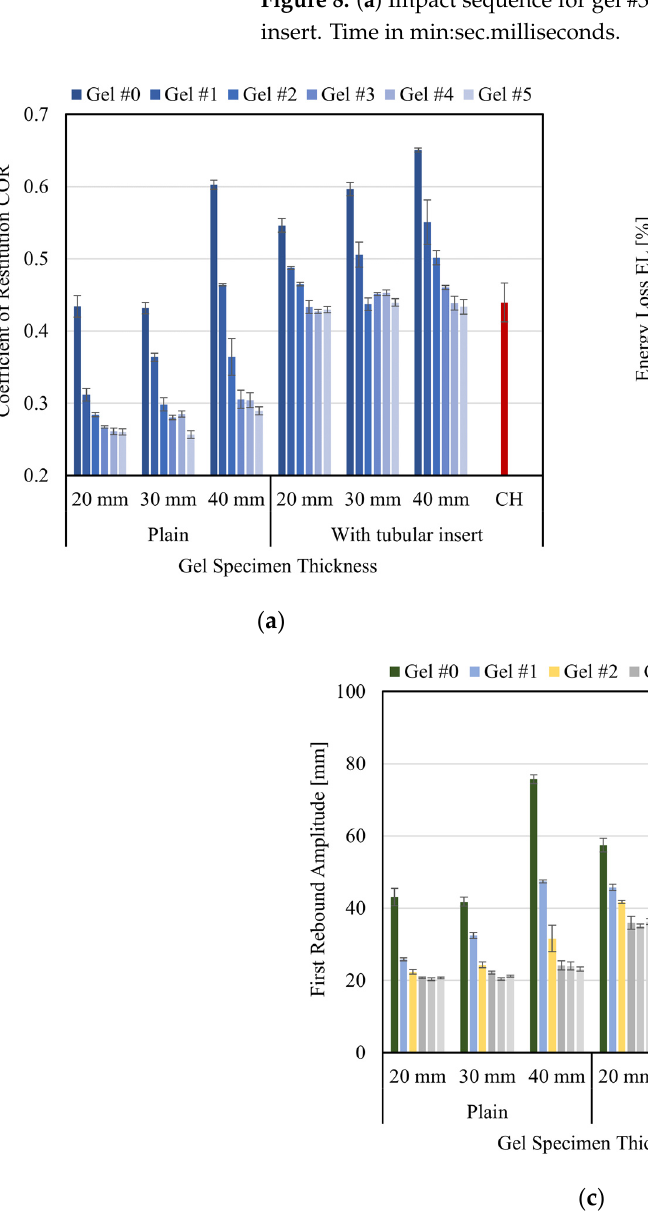
Figure 9. ( a ) Average COR values; ( b ) Average EL values; ( c ) Average elevation of the first rebound. CH values were obtained from [7]. The top error bars correspond to the standard deviation.